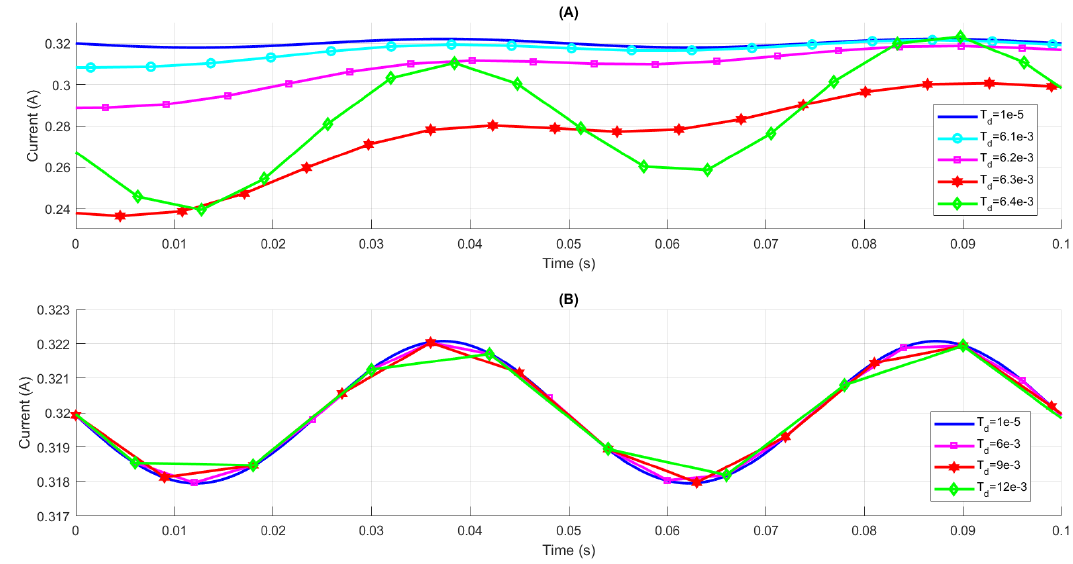
Figure 6. Comparison between 4th Order Runge-Kutta method ( A ) and the proposed method ( B ) with different time